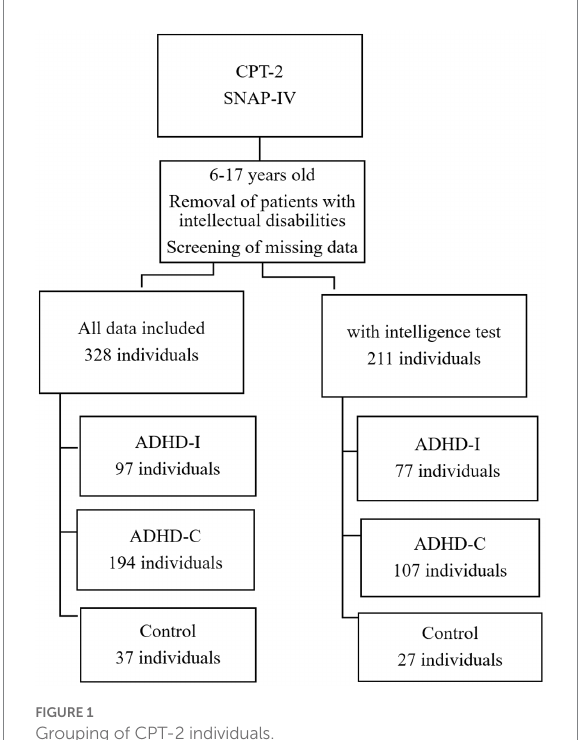
FIGURE 1 Grouping of CPT-2